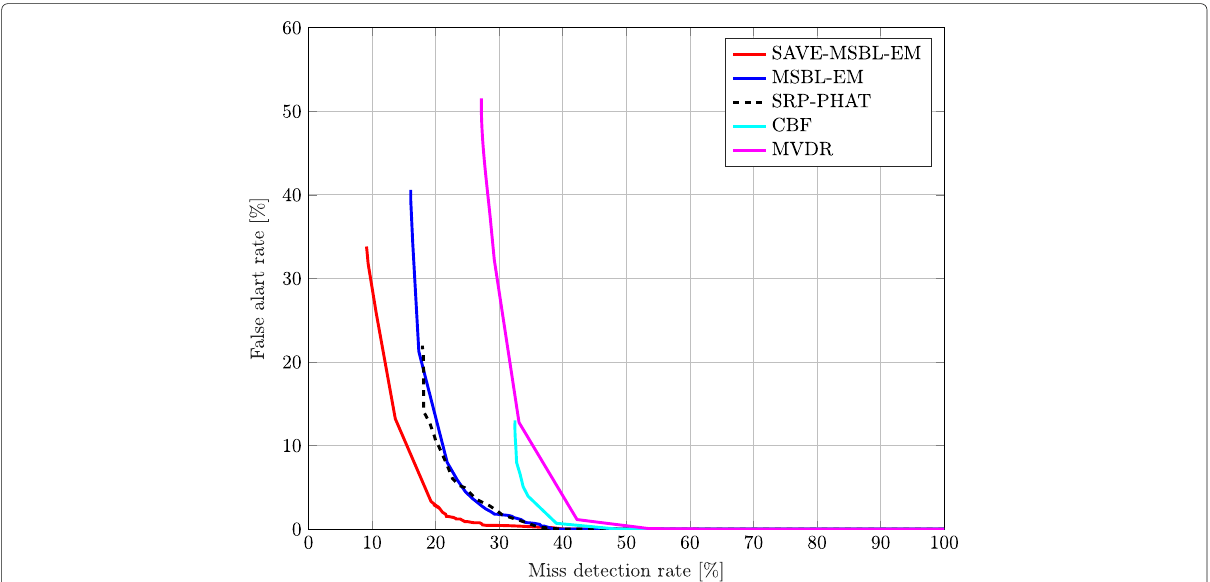
Fig. 14 The MD rate versus FA rate by varying the peak selection